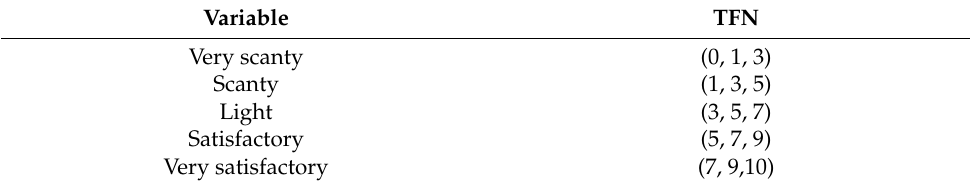
Table 2. Linguistic terms and its